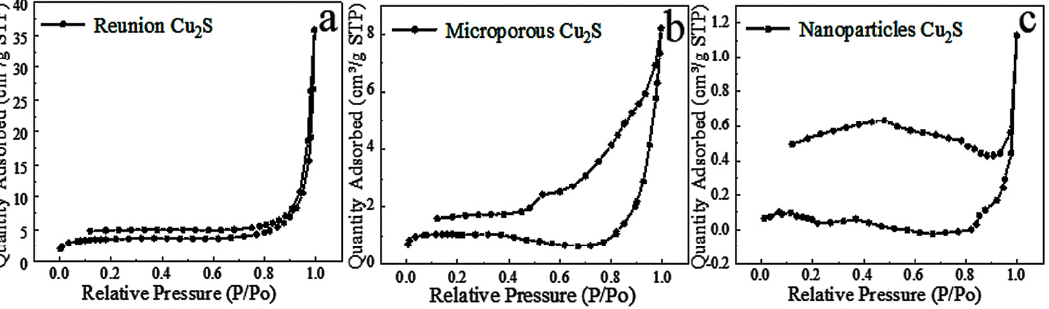
Figure 10. Nitrogen adsorption and desorption isotherms of Cu 2 S with different morphologies.